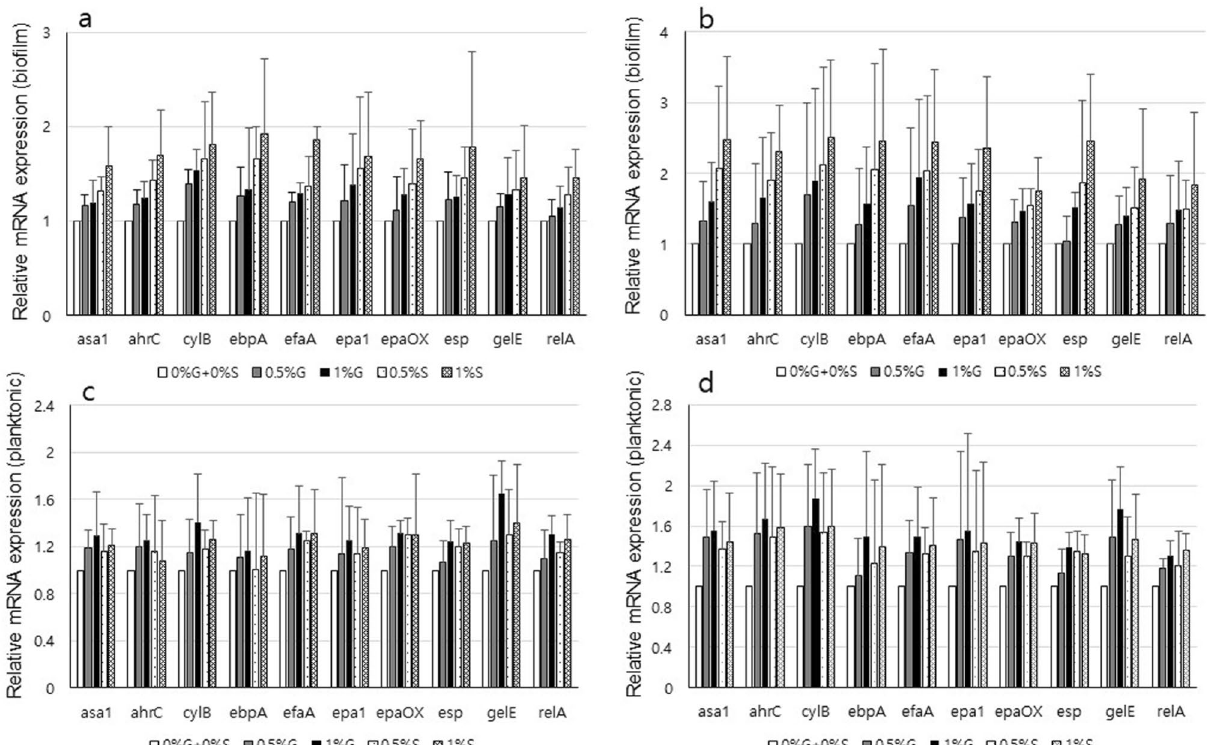
Figure 2. Expression of virulence-associated genes by qRT-PCR. RNA was prepared from E. faecalis ( a and c ) ATCC29212 and ( b and d ) OG1RF grown in 0% glucose + 0% sucrose (0%G + 0%S), 0.5% glucose (0.5%G), 1% glucose (1%G), 0.5% sucrose (0.5%S), or 1% sucrose (1%S). Data represent the mean and standard deviation of at least 3 independent experiments.